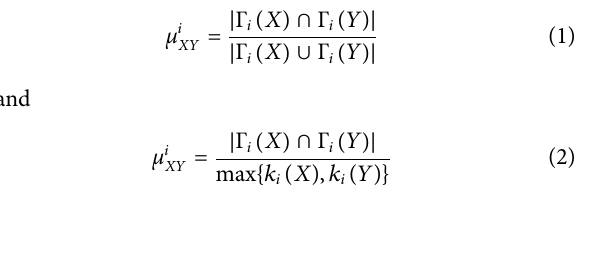
Frontiers in Physics |